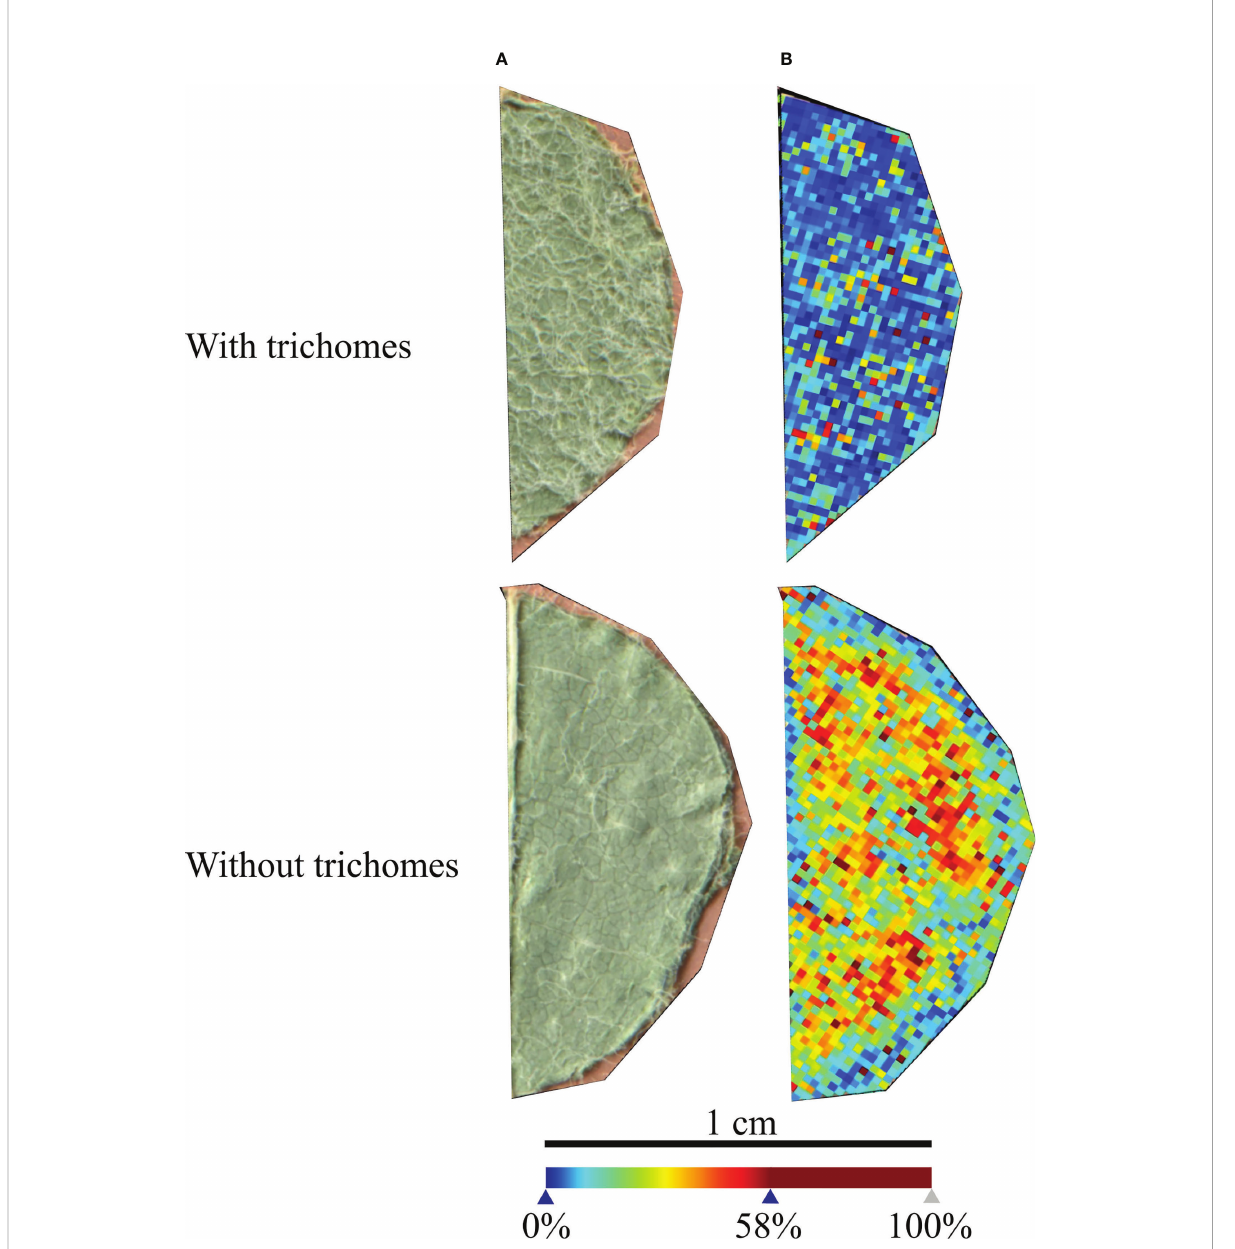
FIGURE 1 Vitis vinifera ‘ Trincadeira ’ leaf discs analysed with and without trichomes. (A) Microscopy images of the leaf disc sections analysed. (B) MALDI- FT-ICR-MS images reconstructed from all the peaks detected in the leaf discs. Spatial resolution: